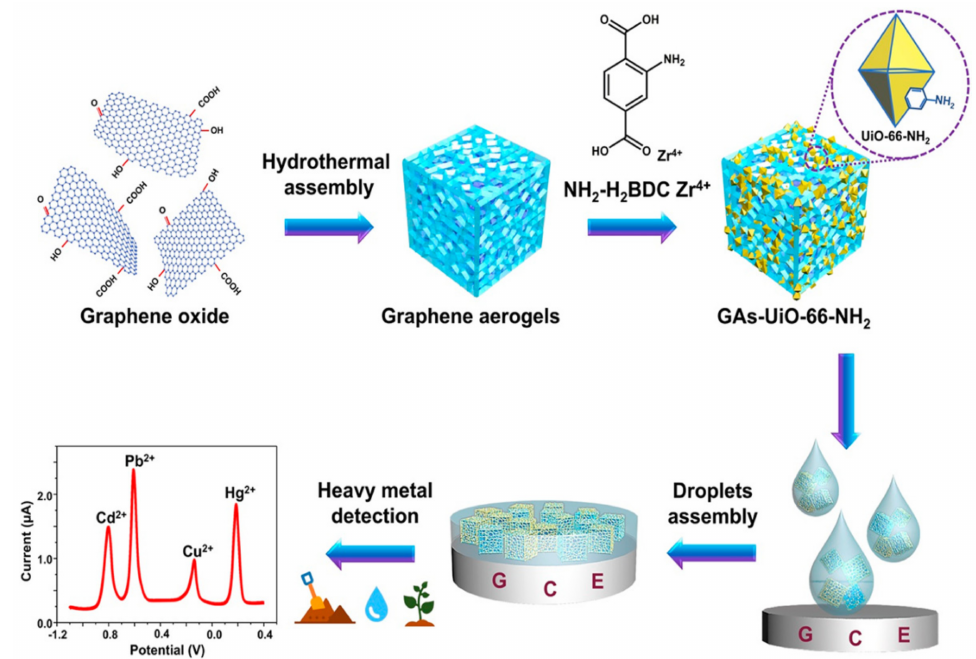
Figure 1. Schematic Illustration of GAs-UiO-66-NH 2 Composite Synthesized via the In Situ Growth of the UiO-66-NH 2 Crystal on GAs Matrix and the Detection of Heavy-Metal Ions by GAs-UiO-66- NH 2 Modified Electrode [34]. Reproduced with permission from Lu et al., Anal. Chem. ; published by the American Chemical Society,